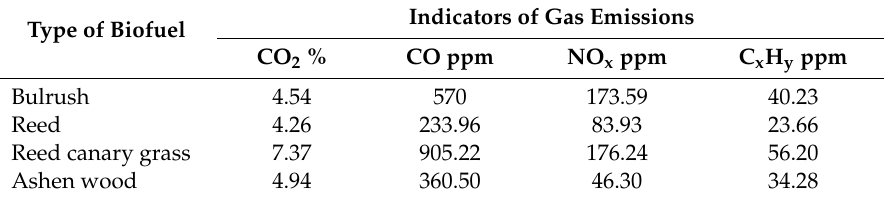
Table 4. Harmful gas emissions of reed